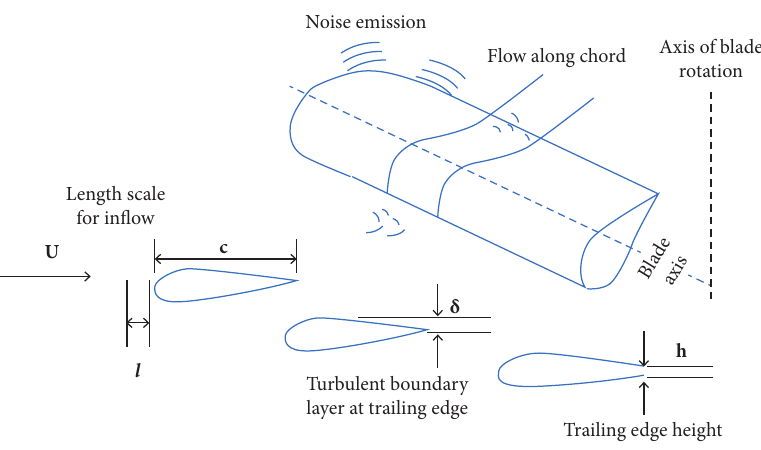
Figure 1. Schematic of major noise mechanisms from wind turbine blade (adapted from Doolan et al. (2012); Grosveld (1985)). Turbulent Boundary Layer Trailing Edge (TBL-TE)